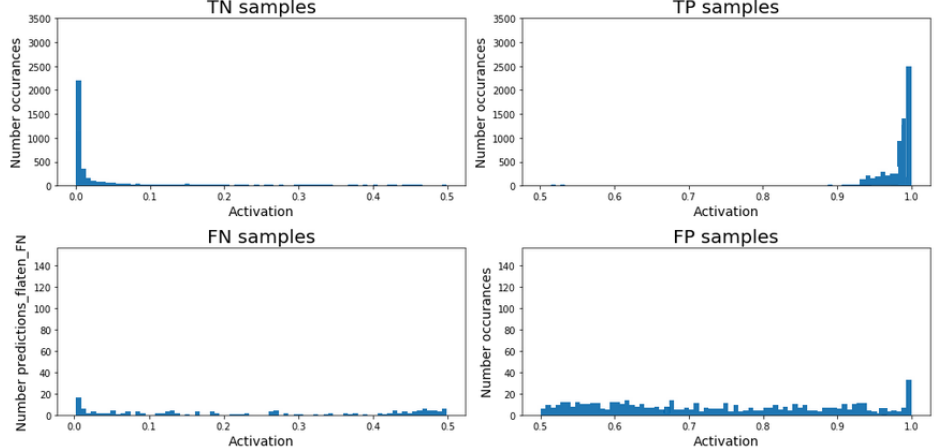
Figure 18. Confidence-level analysis of the RNN-CNN cascade model for tv D6WH (MUAC region). ( top-left ) TN, ( top-right ) TP, ( bottom-left ) FP, and ( bottom-right ) FN cases.